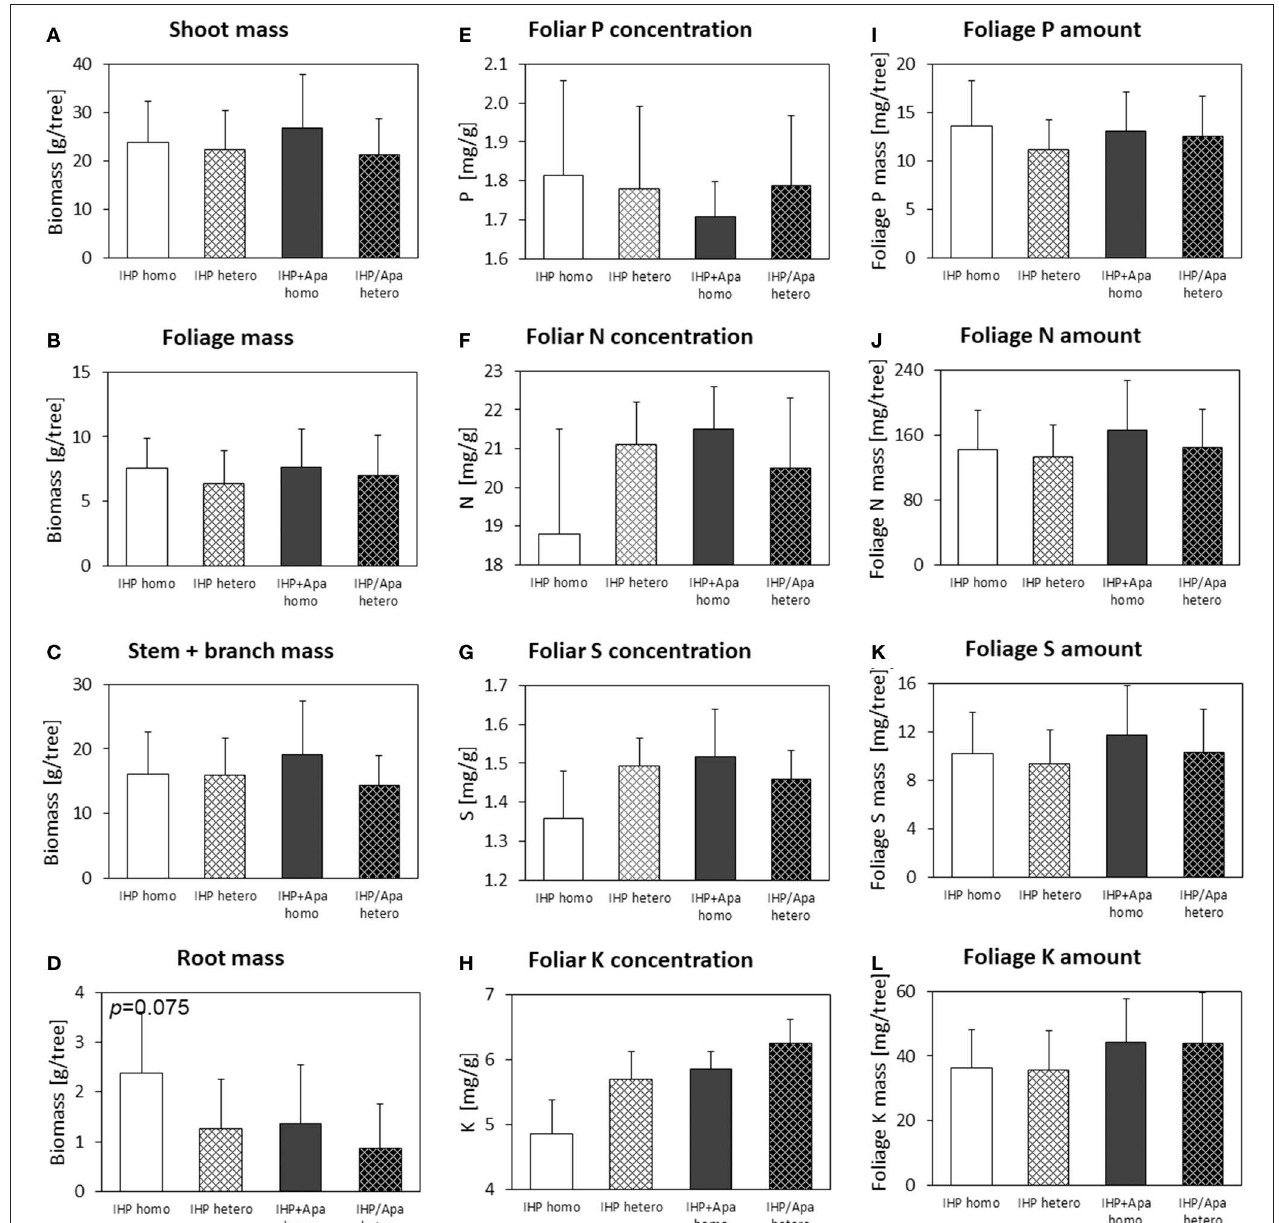
FIGURE 6 | Shoot (A) , foliage (B) , stem+branch (C) , and root (D) biomass, foliar concentrations of N (E) , P (F) , S (G) and K (H) , and nutrient (P, N, S, K) amounts in foliage (I–L) of Fagus sylvatica at the low-P calcareous site. Numbers in the upper left panel corner show p < 0.1 for differences between mean values of homogeneous vs. heterogeneous P application calculated by one-way